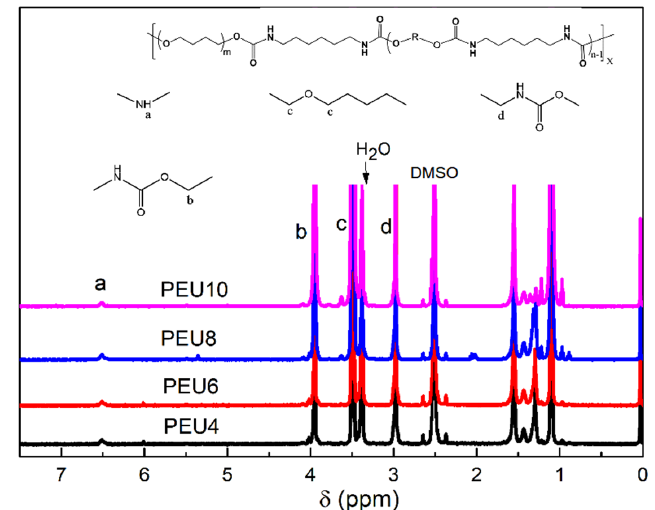
Figure 3. 1 H NMR spectra of PEU.